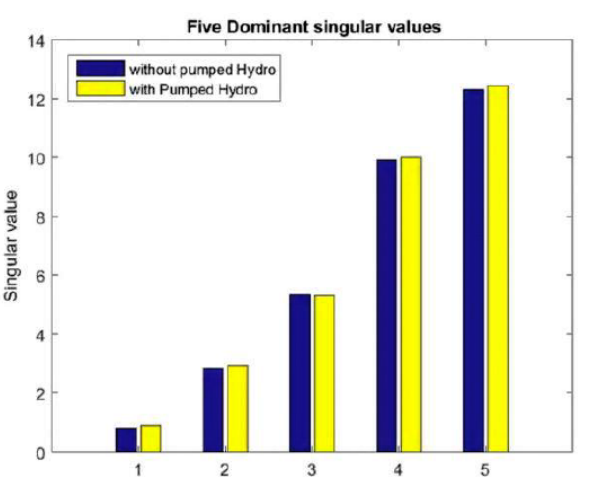
Figure 13. Result plot with and without PHG: Period 46.